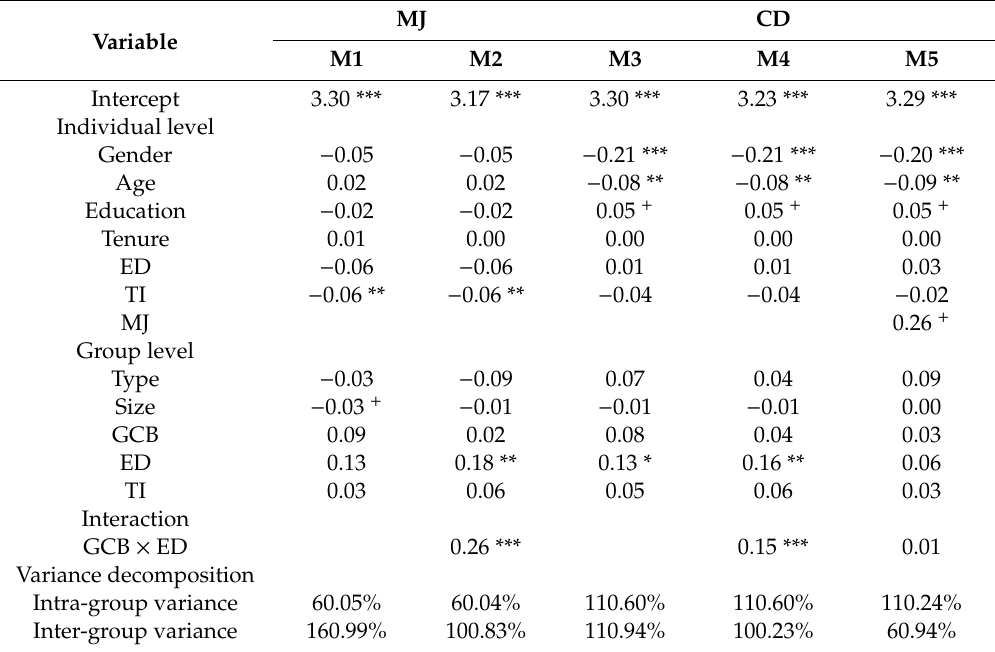
Table 4. Main e ff ect and moderating e ff